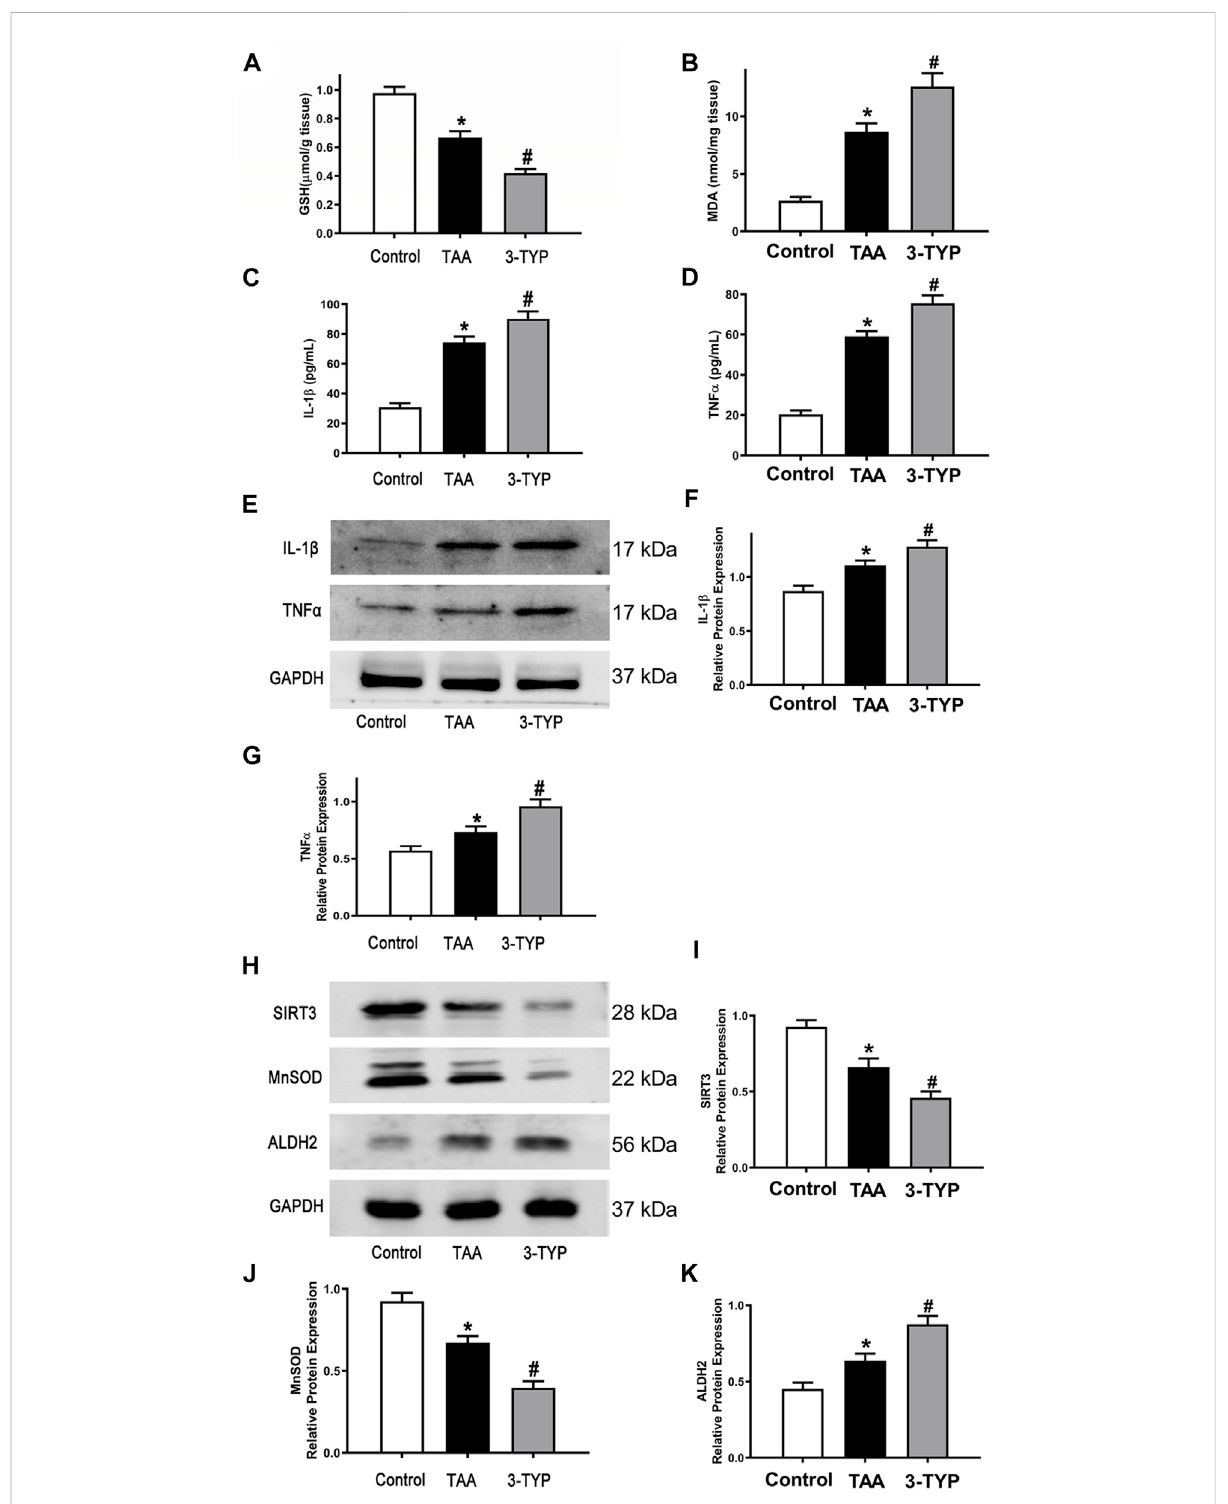
Effect of 3-TYP on in fl ammatory response in each group, n = 10 per group. (A) liver contents of GSH in liver tissues. (B) the MDA level in liver tissues. (C) theserumIL-1 β levels. (D) theserumTNF- α levels. (E) TheproteinexpressionsofIL-1 β andTNF- α inlivertissueswereanalyzedbywestern blotting. (F) The quantitative values of IL-1 β . (G) The quantitative values of TNF- α . (H) The protein expressions of SIRT3, MnSOD, and ALDH2 in liver tissues were analyzed by western blotting. (I) The quantitative values of SIRT3. (J) The quantitative values of MnSOD. (K) The quantitative values of ALDH2. * p < 0.05, vs . the control group. # p < 0.05, vs . the TAA